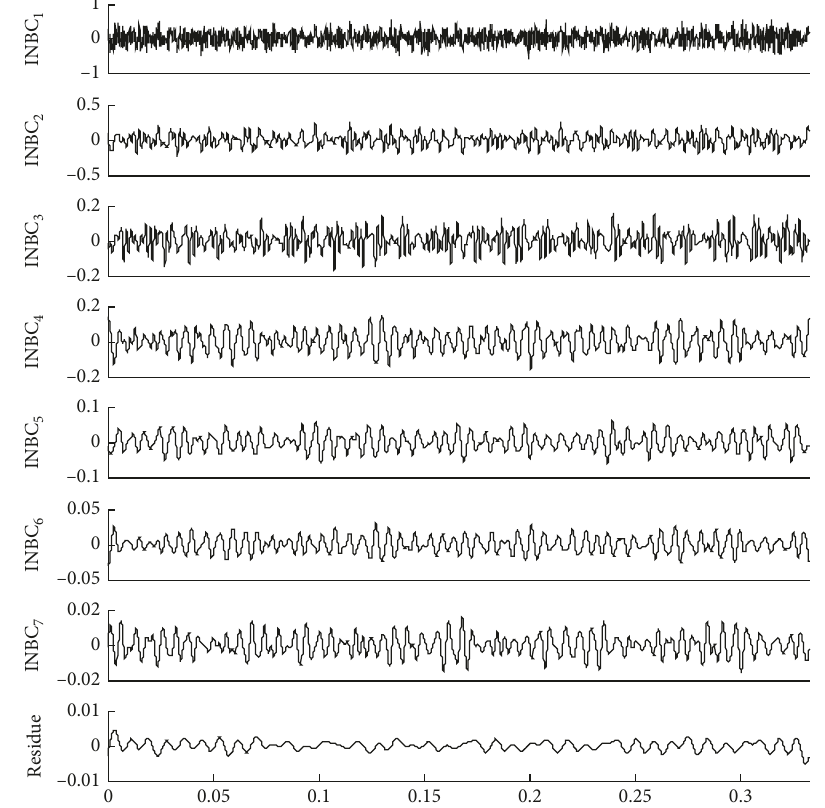
Figure 13: The decomposing results generated by ASNBD of a vibration signal from class